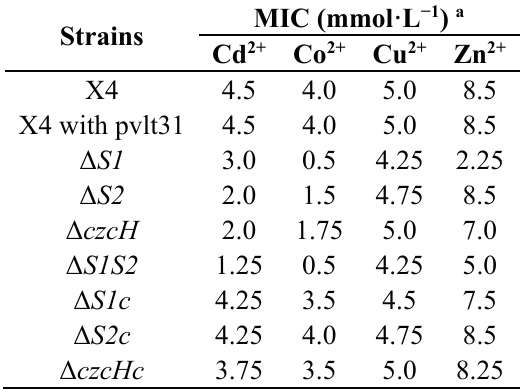
Table 1. Minimum inhibitory concentrations (MICs) of cadmium, cobalt, copper, and zinc in various derivatives of P. putida